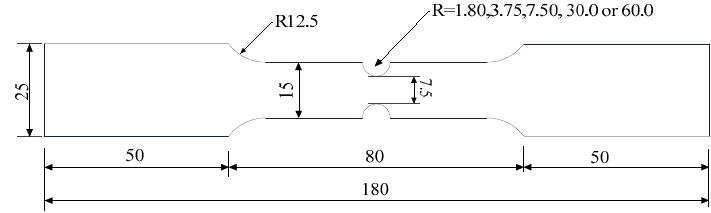
Figure 4. Dimensions of notched specimens for tensile tests (unit: mm).